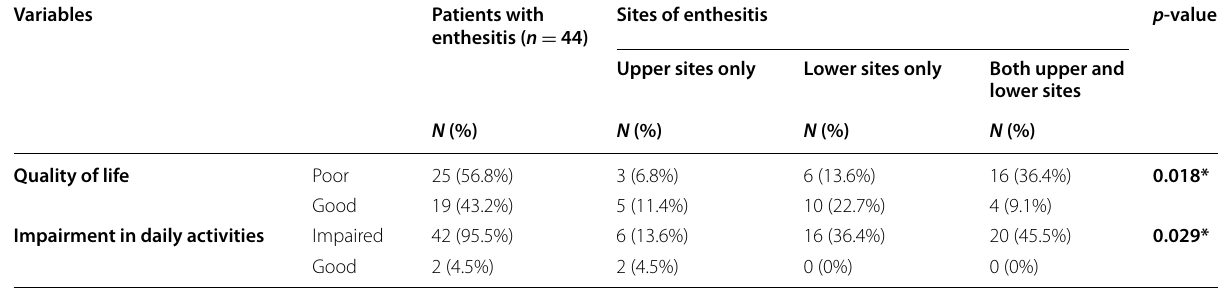
Table 5 Quality of life and daily activity impairment in patients suffering from psoriasis-related enthesitis based on the location of SPARCC enthesitis